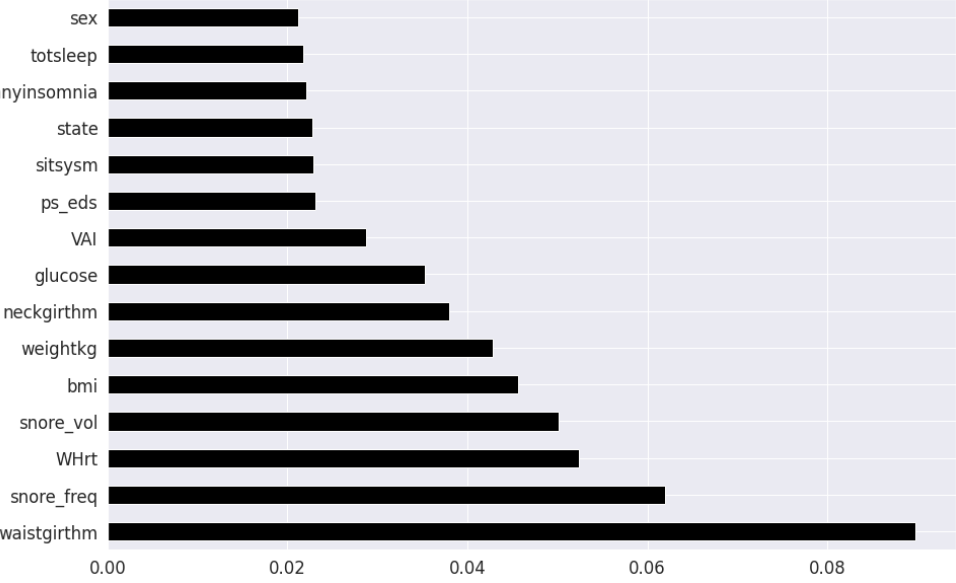
Figure 5. Clinical features ordered as per Mutual Information.